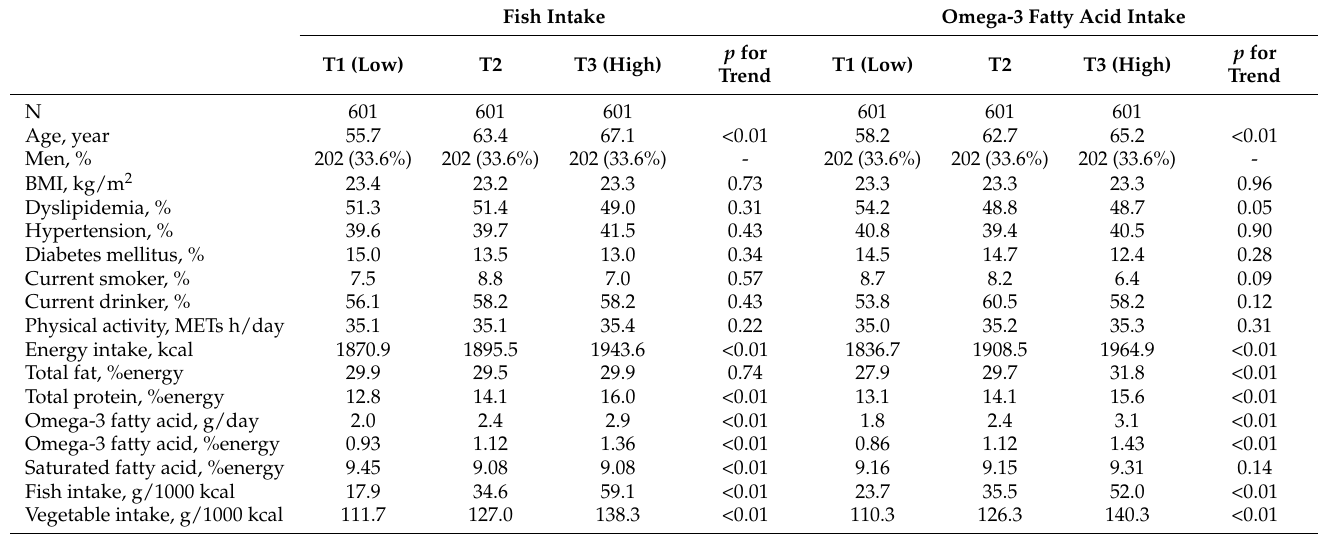
Table 1. Demographic characteristics reported by fish and omega-3 fatty acid intake tertiles. Fish Intake